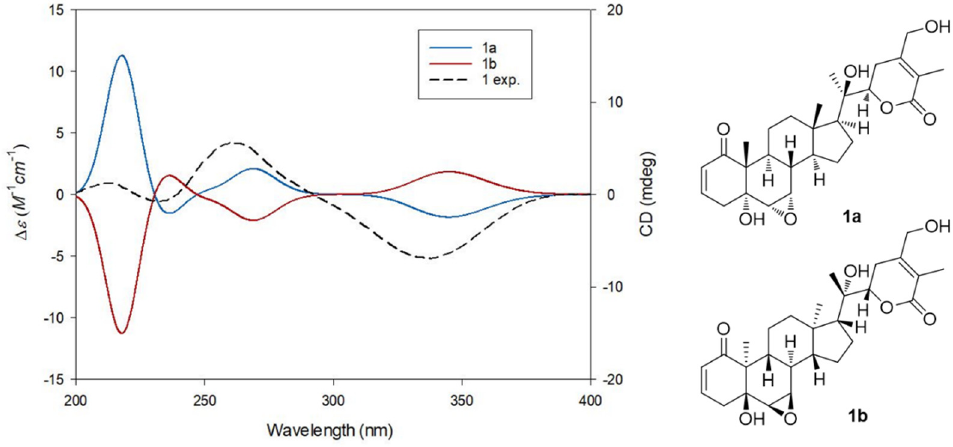
Figure 4. Experimental and calculated ECD data of 1 .